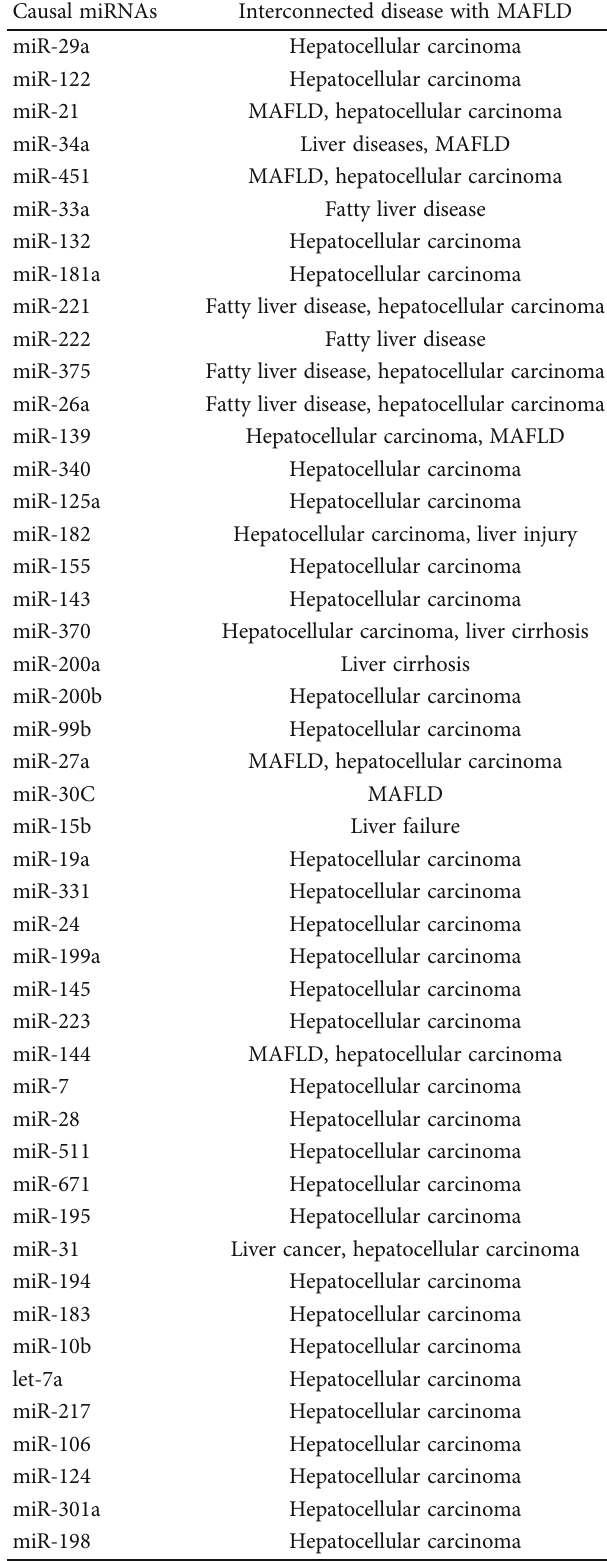
Table 4: Causal miRNAs associated with fatty liver disease and